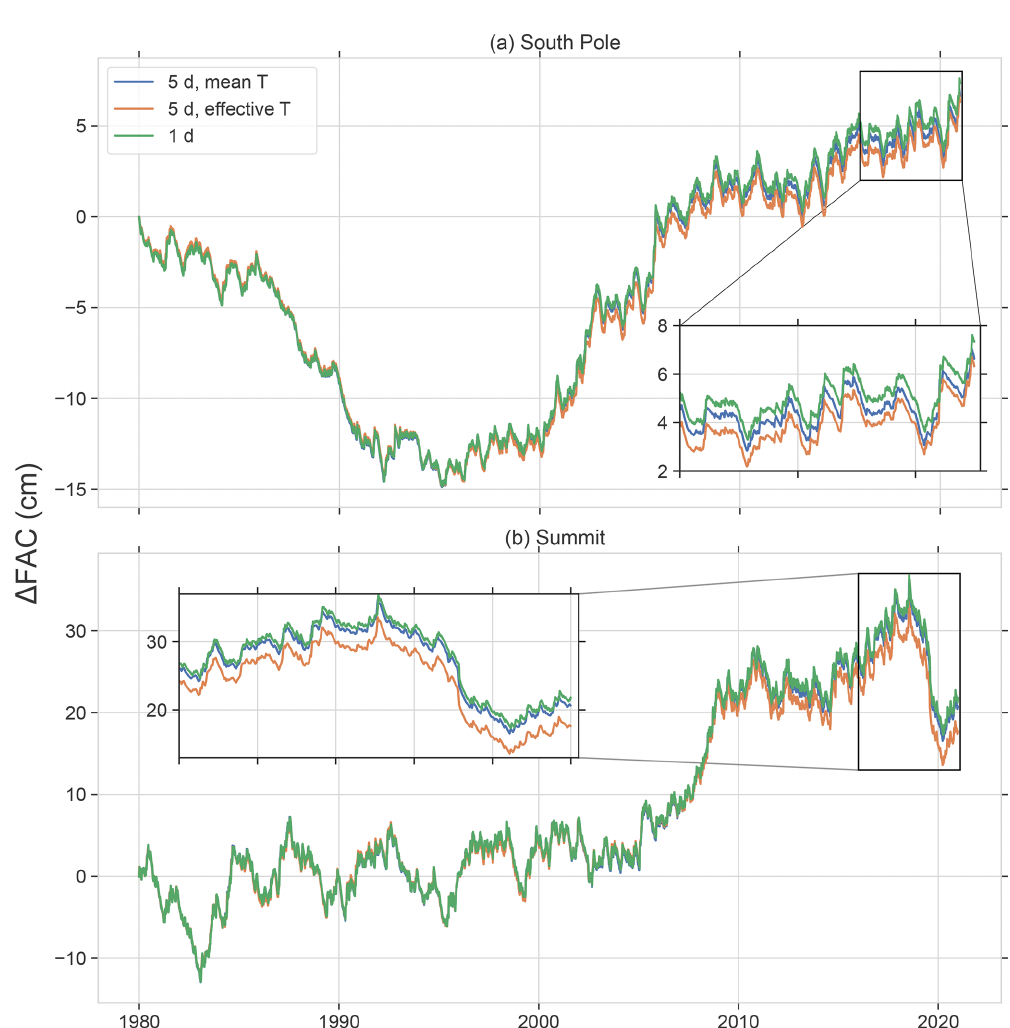
Figure C1. The change in FAC for the duration of the model run for the South Pole (a) and Summit (b) for each of the three model run types.